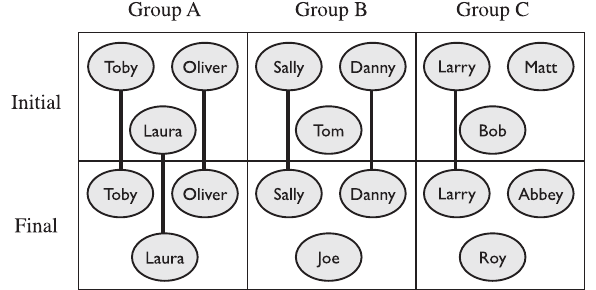
FIG. 1. Group membership at the beginning and at the end of the semester. All names are